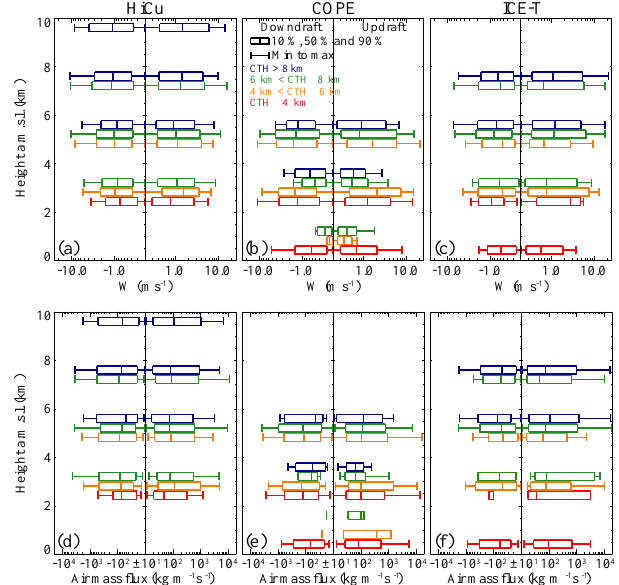
Figure 12. Profiles of (a–c) the vertical velocity and (d–f) the air mass flux for the updraft and downdraft with air mass flux ≥ 10kgm − 1 s − 1 in magnitude. The red, orange, green, and blue boxes represent clouds with cloud top heights of 0–4, 4–6, and 6– 8km and higher than